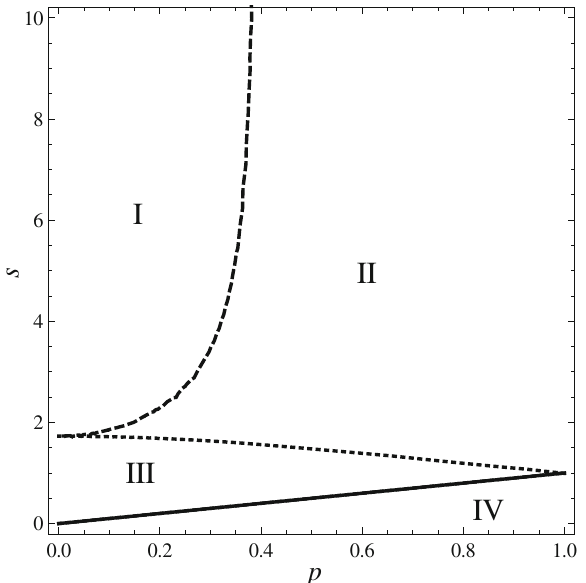
Fig. 14 PhasediagramofKerr–AdSblackholesinthestandardmodel. On the dashed curve C J , while on the dotted curve C Ω diverges. In region I, C Ω < 0 and C J < 0, in region II, C Ω < 0 and C J > 0, and in region III, C Ω > 0 and C J > 0. In region IV, there is no physical solution because | a | > l